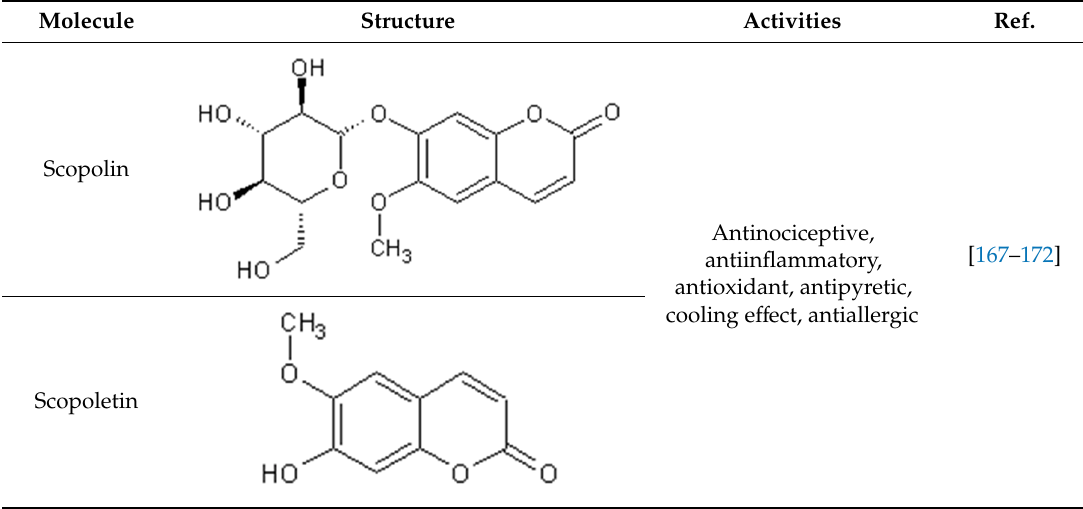
Table 4. Structure and biological activities of major coumarins of Artemisia annua